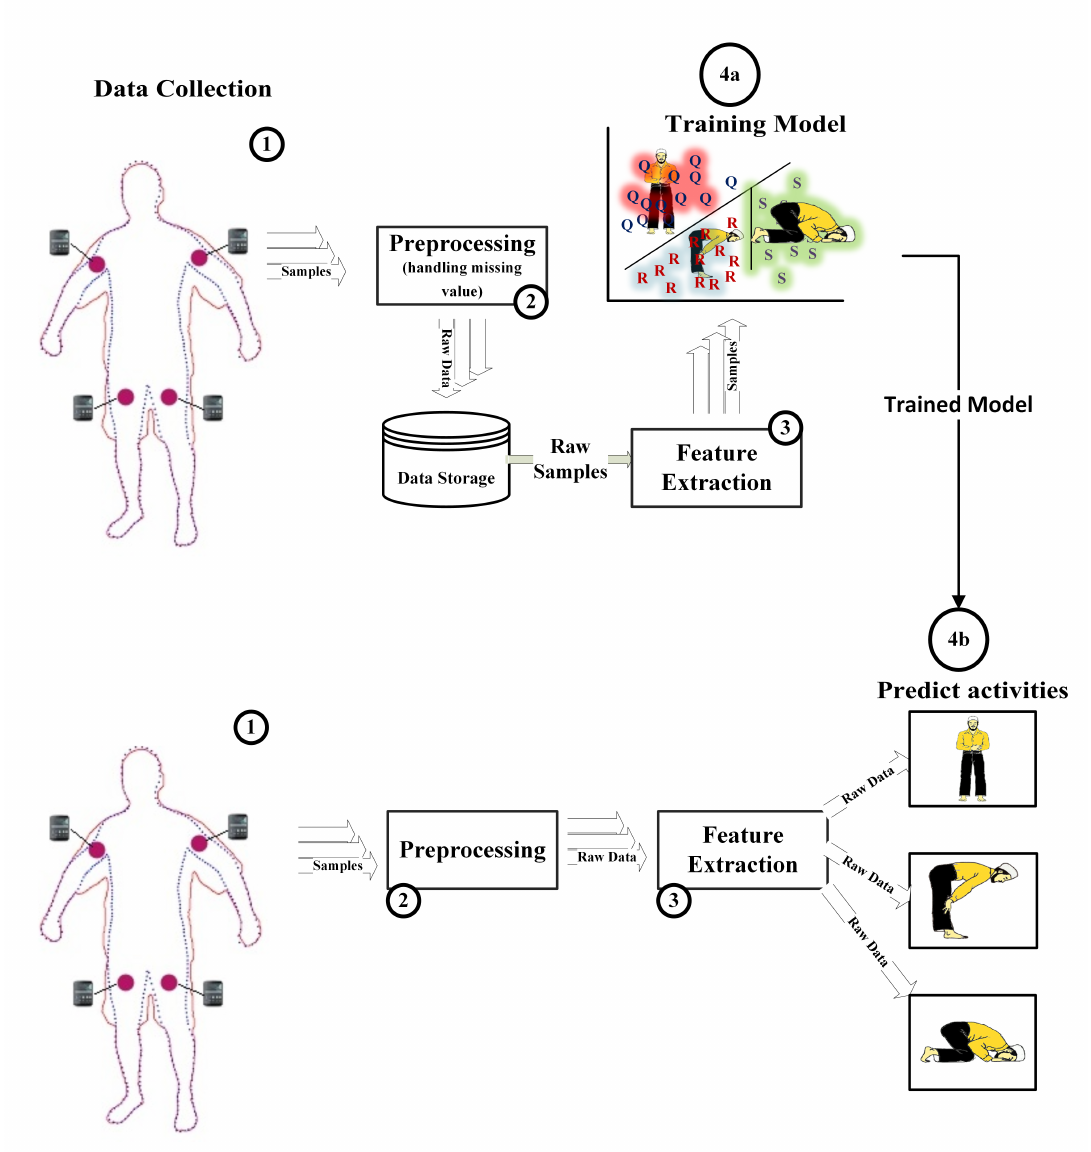
Figure 2. Framework of the Salah activities recognition model